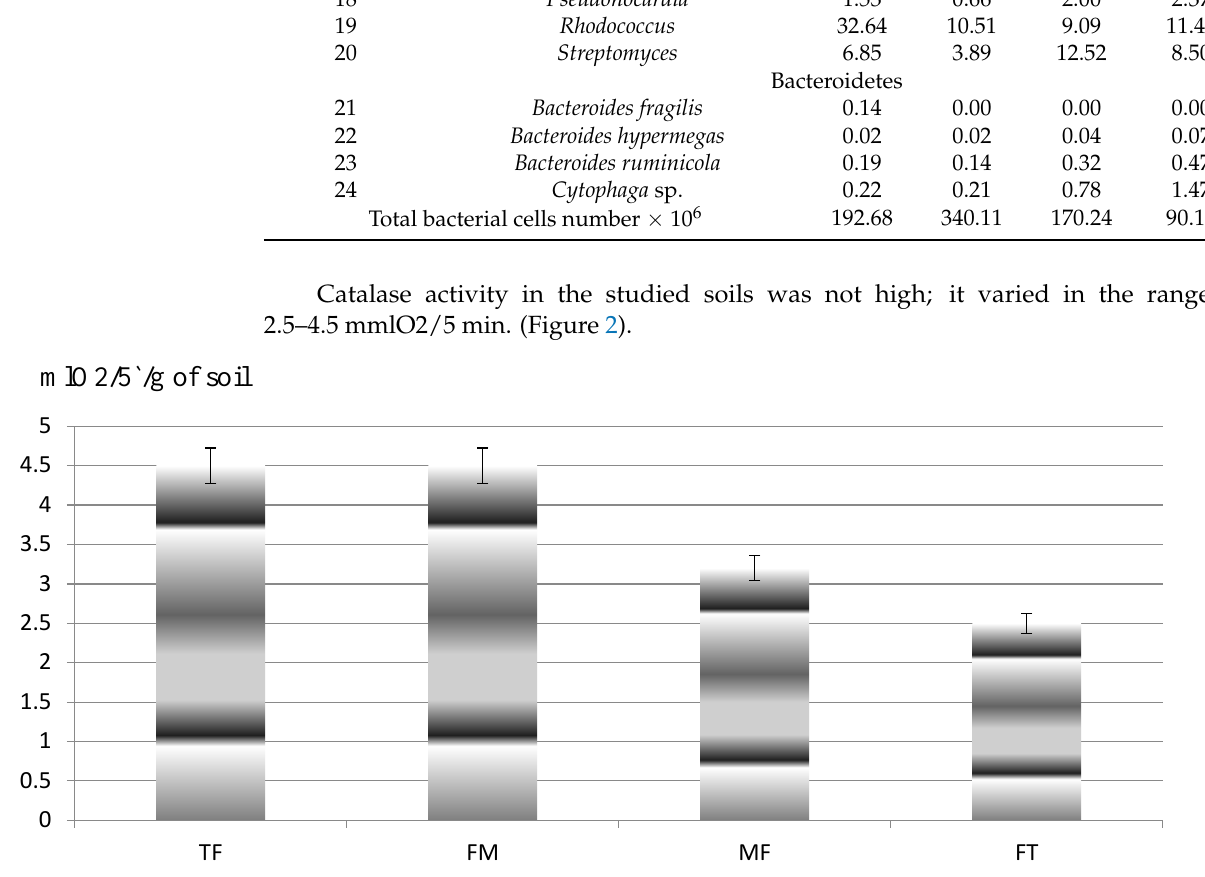
Figure 2. Change in catalase activity in soils gradient of the altitude zone of Mount Kivakka.